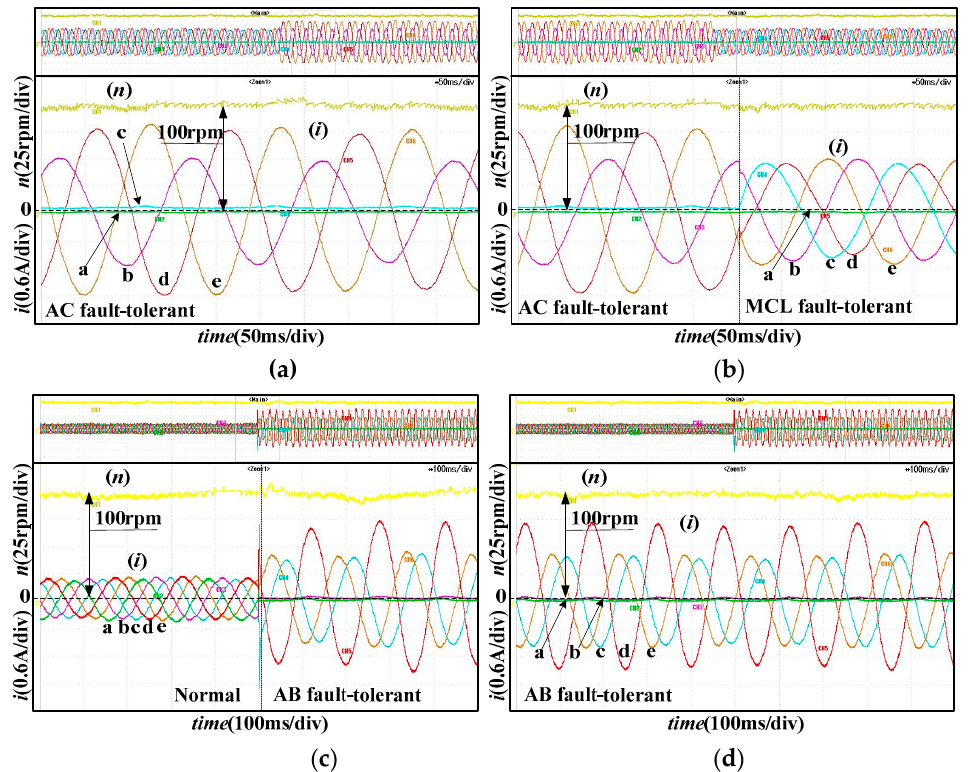
Figure 13. Fault-tolerant current and speed waveforms with double open-phase condition: ( a ) AC fault-tolerance; ( b ) AC fault-tolerance to MCL fault-tolerance; ( c ) normal to AB fault-tolerance; ( d ) AB fault-tolerance.